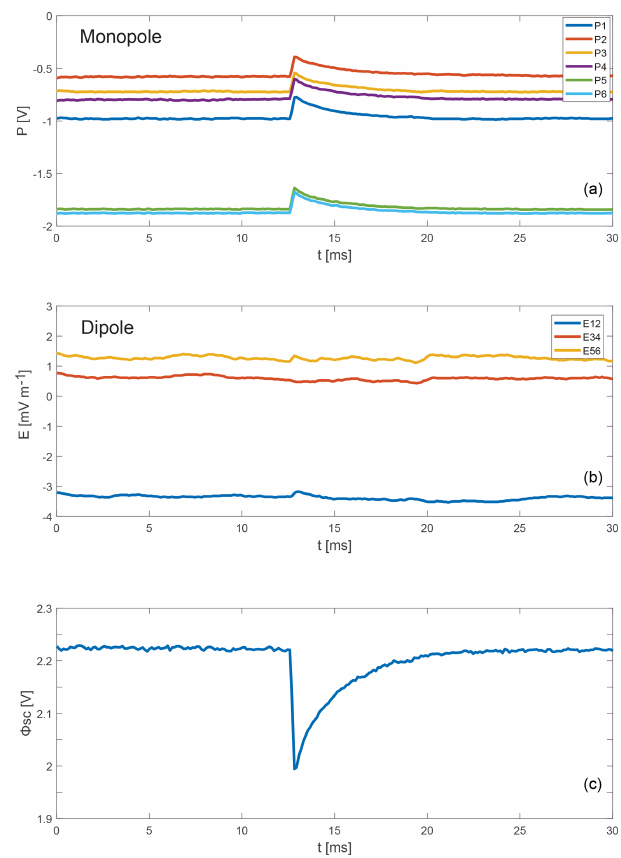
Figure 6. A potential signal of dust impact measured with MMS. Example of a typical event related to the change of the spacecraft potential observed in monopole configuration (a) , the dipole mea- surements (b) with a lack of signal and the derived voltage pulse in (c) (see Vaverka et al.,